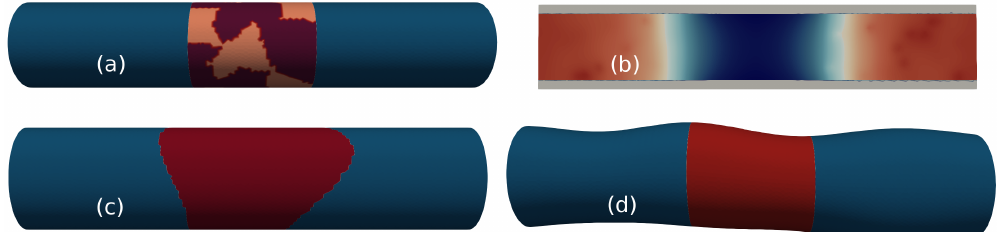
Figure 4. Examples of different sources of variability applied to the 10 nm gate length GAA-NW FET: ( a ) TiN metal profile (with work-function values of 4.4 eV and 4.6 eV) applied to the device gate leading to metal grain granularity (MGG) variations, ( b ) effect of the random dopants (RD) present in the source/drain regions of the device on the device electron concentration, ( c ) device gate affected by gate edge roughness (GER) and ( d ) device body under line edge roughness (LER)